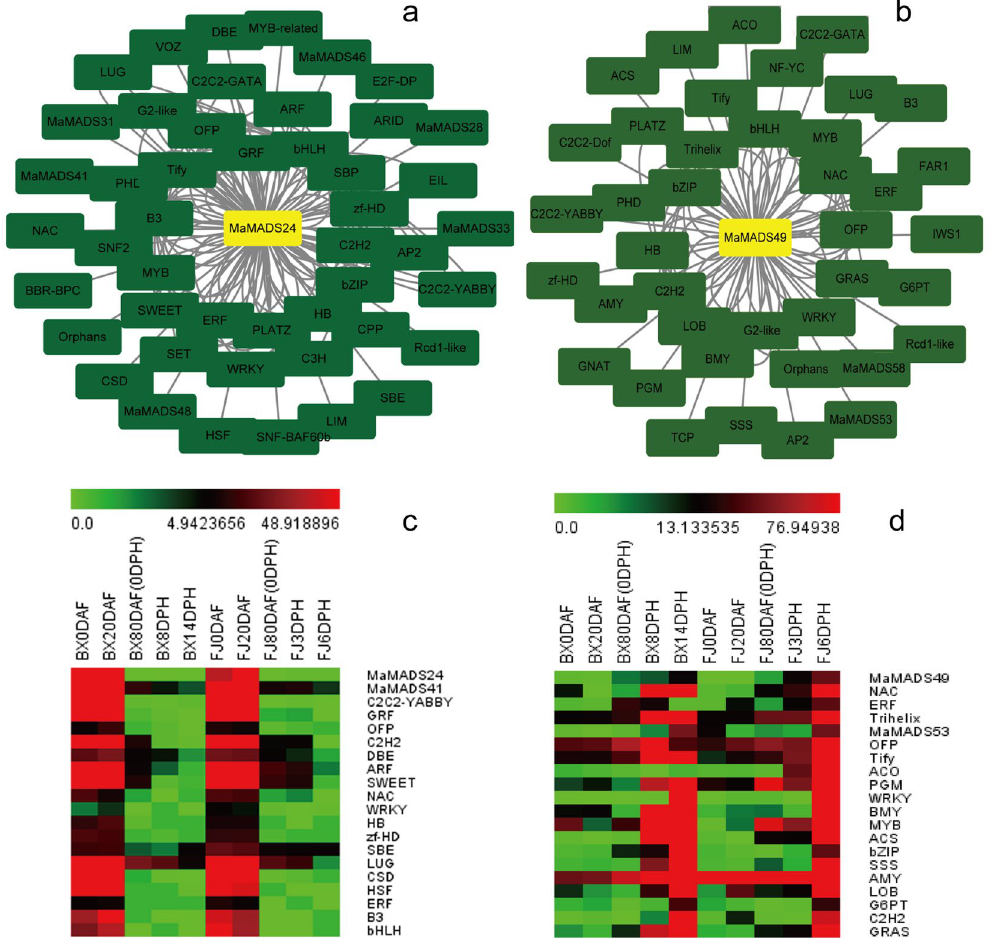
Figure 7. The interactive networks of MaMADS24 and 49 using Cytoscape and validation by qRT-PCR. ( a ) interaction network of MaMADS24 during fruit development process; ( b ) interaction network of MaMADS49 during fruit ripening process; ( c ) validation of the 19 genes interacted with MaMADS24; ( d ) validation of the 19 genes interacted with